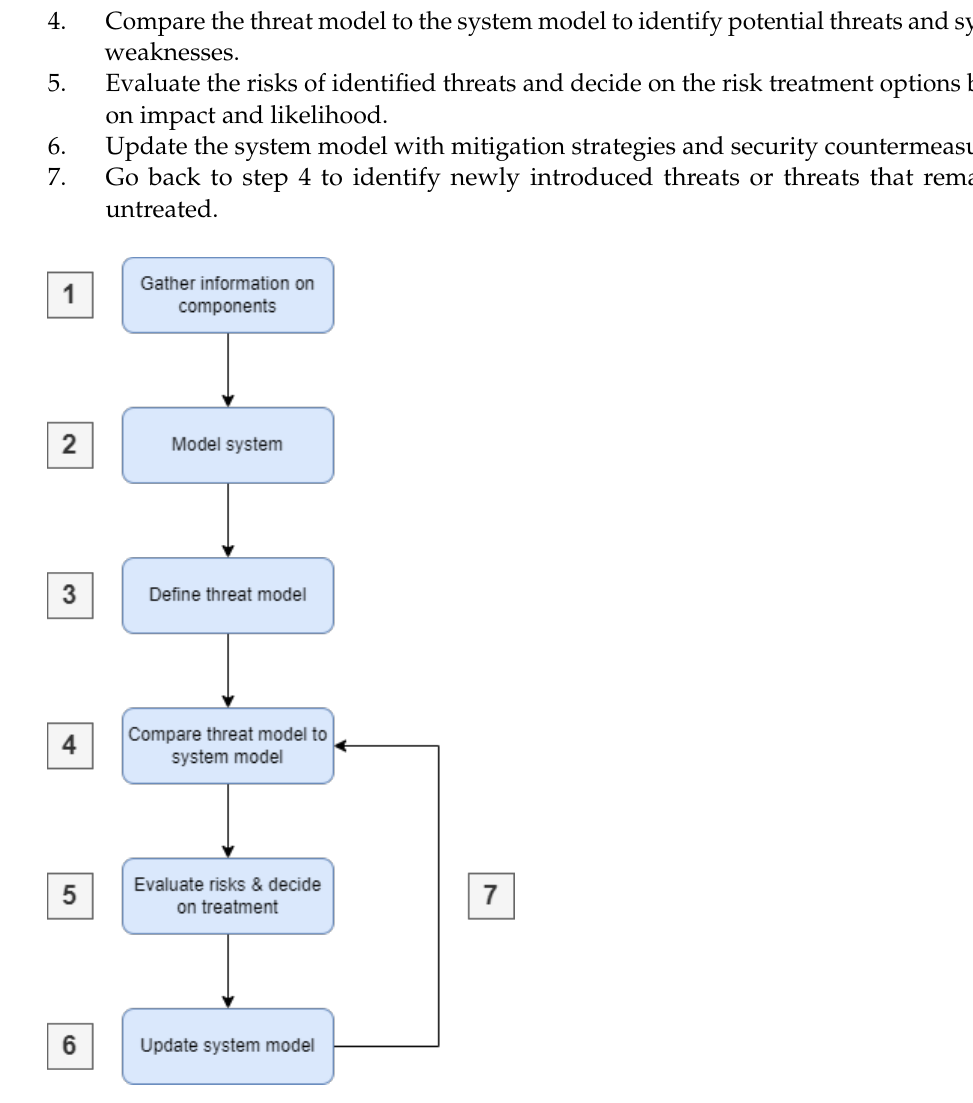
Figure 1. An illustration of the threat modeling process based on